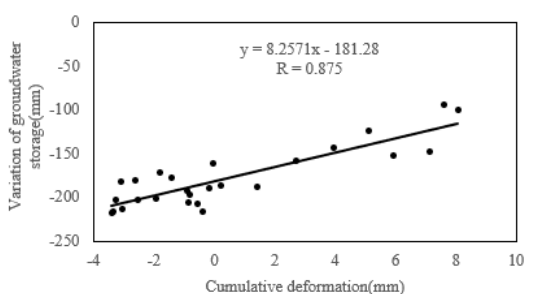
Figure 7. Correlation between cumulative shape variables and changes in groundwater reserves